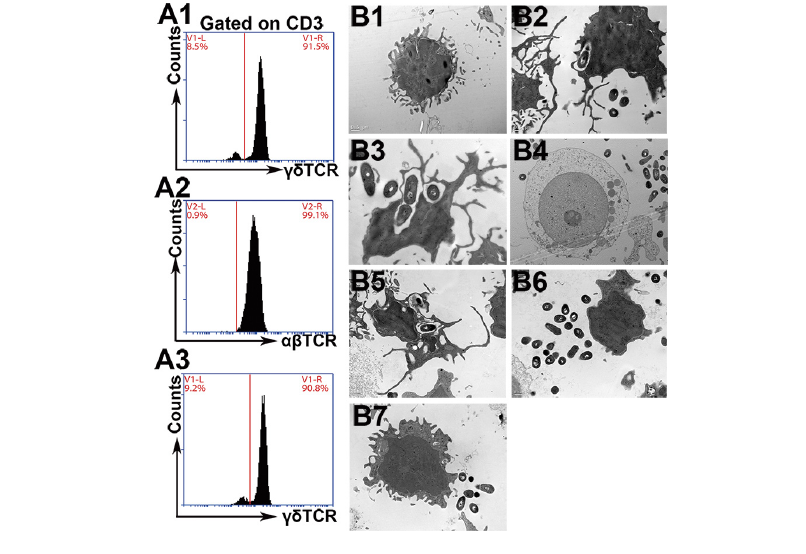
Figure 1. Human γδ T cells possess phagocytic capacity. (A) FCM analysis of γδ T cells and αβ T cells before incubation with L. monocytogenes. (A1) The percentage of γδ T cells in PBMCs at 10 d culture with RPMI 1640 medium containing IL-2 after stimula- tion in anti-pan-TCR γδ mAb-coated plates for five days. (A2) The percentage of αβ T cells after stimulation with CD3 and CD28 antibodies for four days. (A3) FCM analysis of naïve γδ T cells sorted from fresh isolated PBMCs. (B) Representative TEM images of L. monocytogenes phagocytosis. (B1) Activated γδ T cells displayed “hairy” appearance after 10 d culture with anti- γδ TCR antibody and IL-2. (B2) Activated γδ T cells packaged L. monocytogenes bacterium by pseudopod-like plasma membrane after one hour